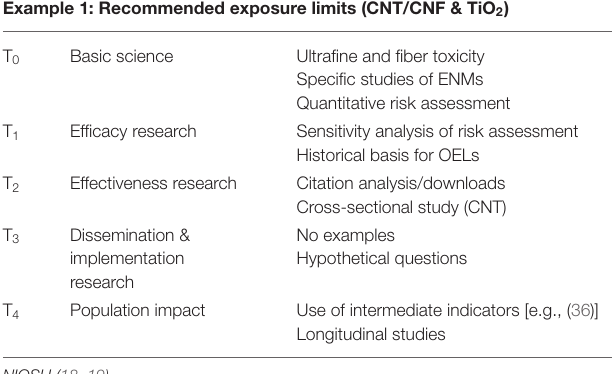
TABLE 3 | Utilization of translational science pertaining to NIOSH recommended exposure limits for TiO 2 and CNT/CNF. Example 1: Recommended exposure limits (CNT/CNF & TiO 2 )